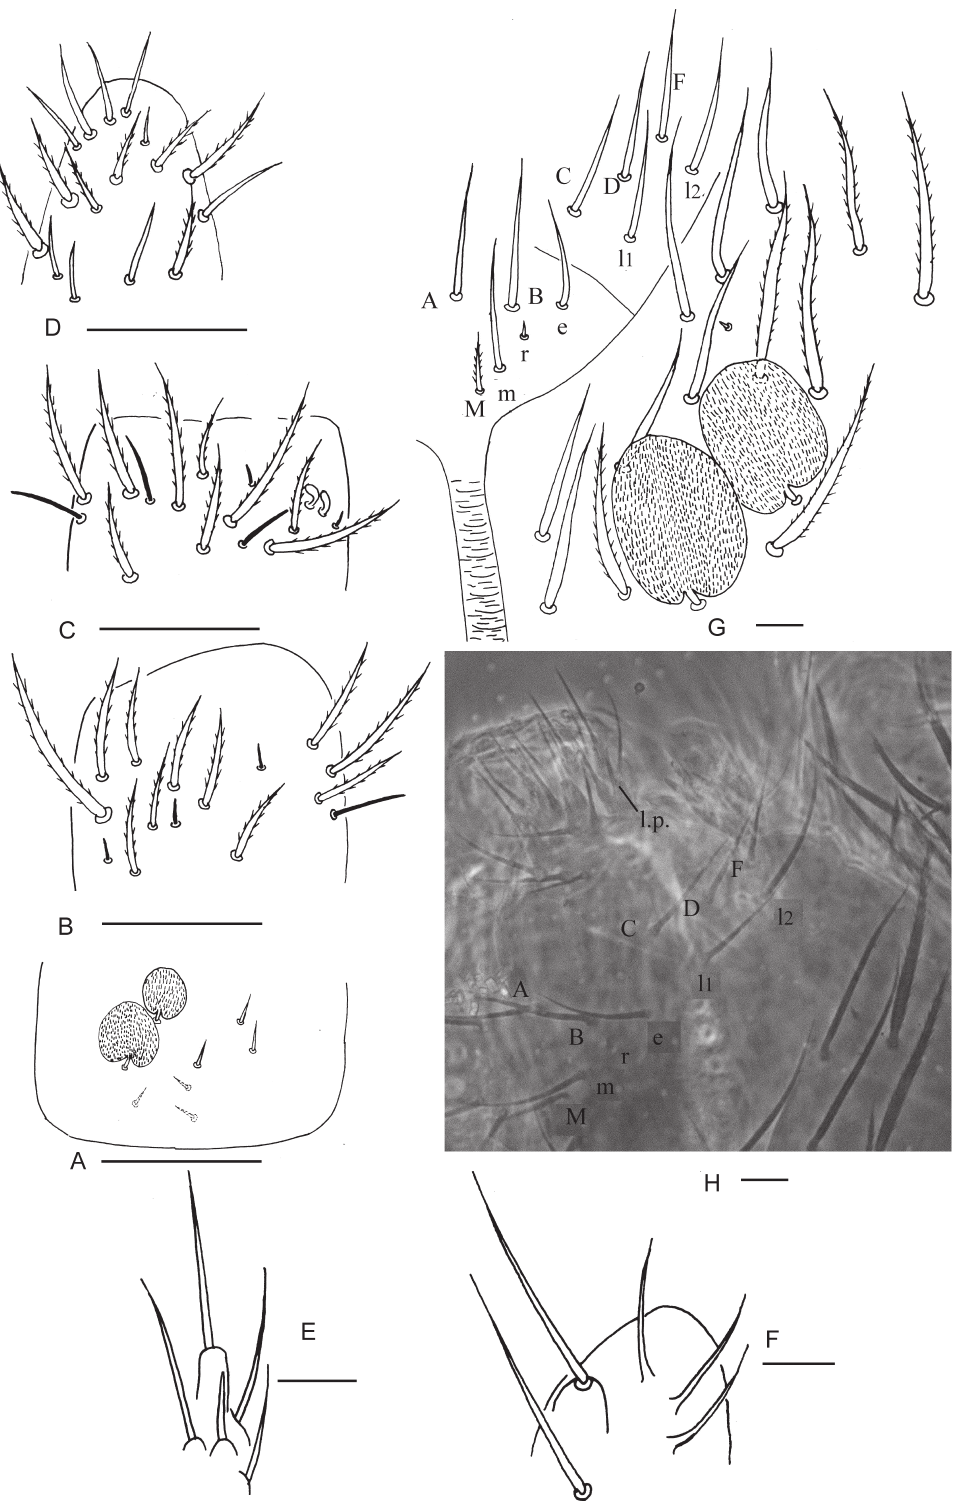
Fig. 11. Lepidocyrtus ( S. ) wanningensis sp. nov. A . Apex of Ant. IV (left side). B . Distal part of Ant. III (lateral side). C . Distal part of Ant. II (left side). D . Basal part of Ant. I (ventral side). E . Lateral process of labial palp (lateral view). F . Maxillary outer lobe (left side). G . Labial and mental chaetotaxy (right side). H . Labial palp and labium (right side). Scale bars: 20